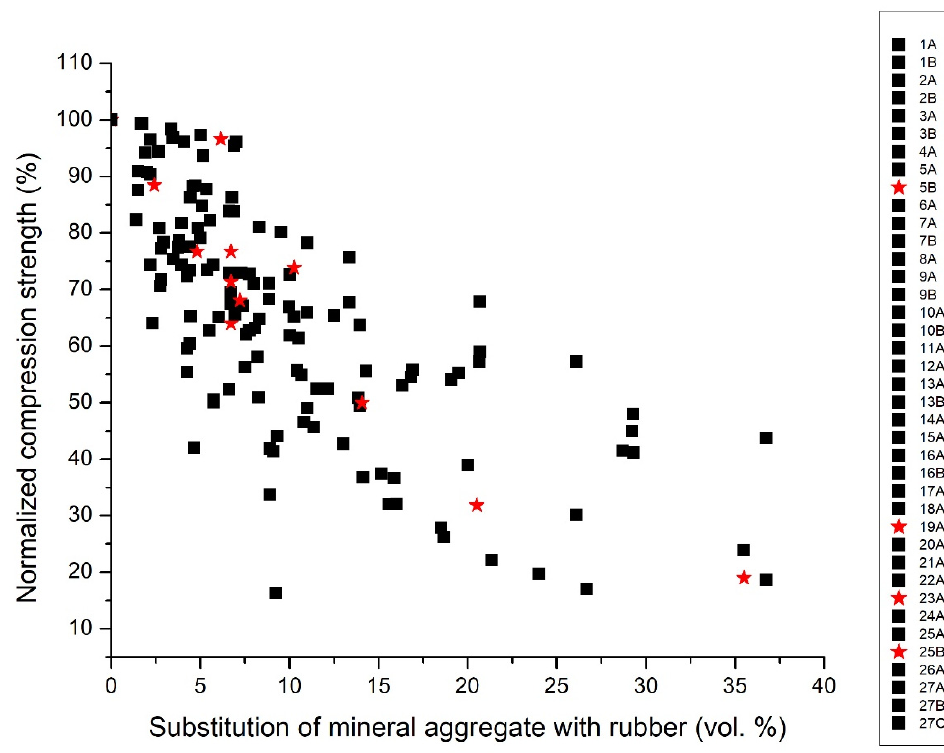
Figure 3. Reference diagram: normalized compression strength (expressed in %) vs. the volumetric percentage of substitution of the mineral aggregate with rubber (expressed in vol.%) recalculated using the fixed values of reference specific weight. Effect of the rubber pre-treated in NaOH (red stars) and rubber without any treatment in NaOH (black squares).